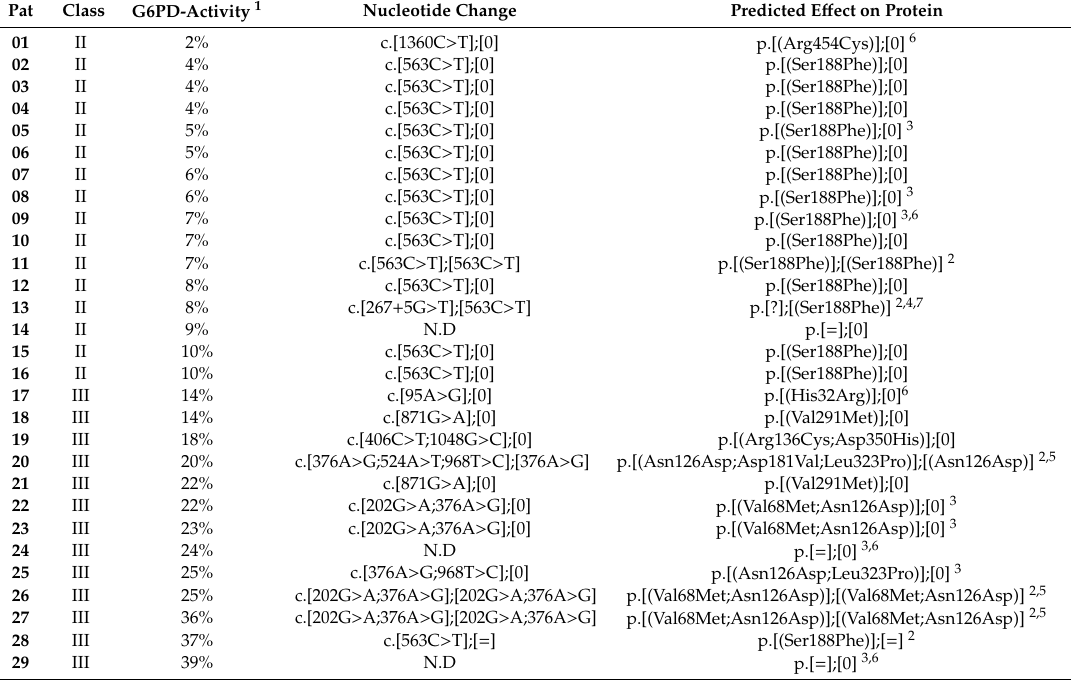
Table 3. Classification and genotypes of newborn infants with activity ≤ 40% of the days